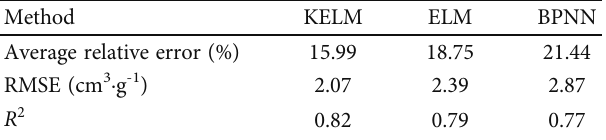
Table 3: Error results of three methods on the same testing dataset.